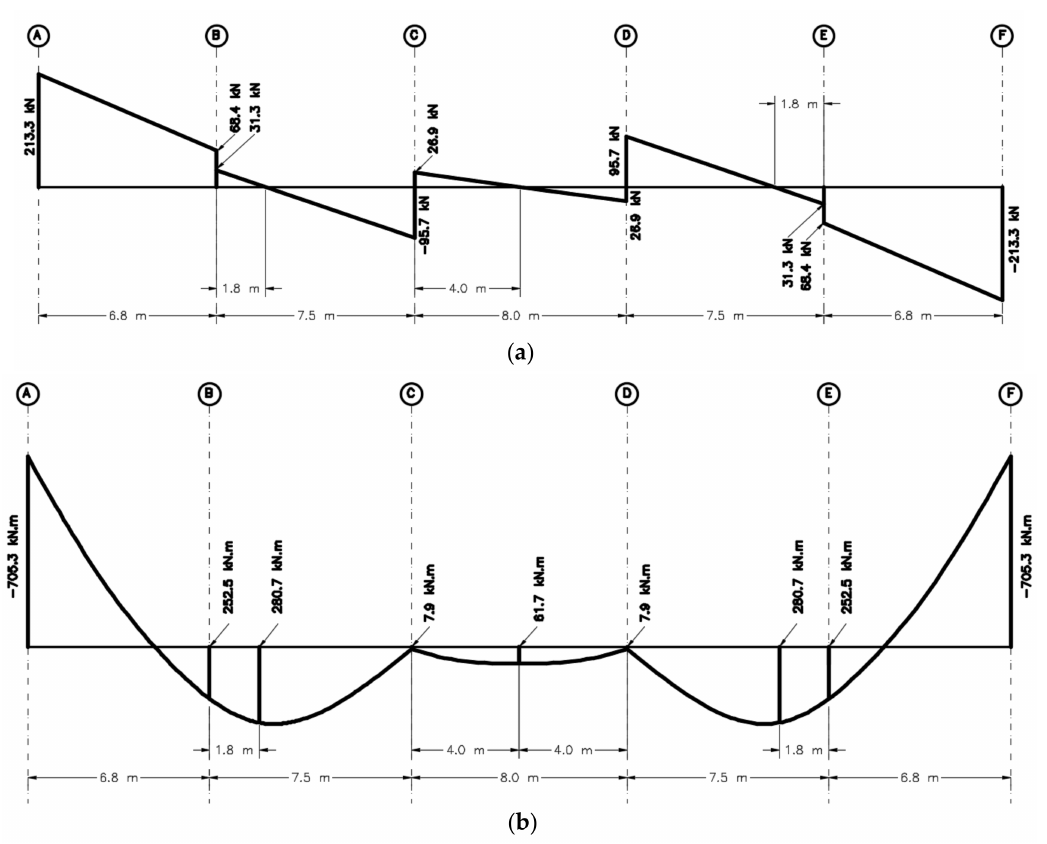
Figure 11. Efforts in beam V2 to the infinite time, after iterative process: ( a ) shear force (kN); ( b ) bending moment (kN